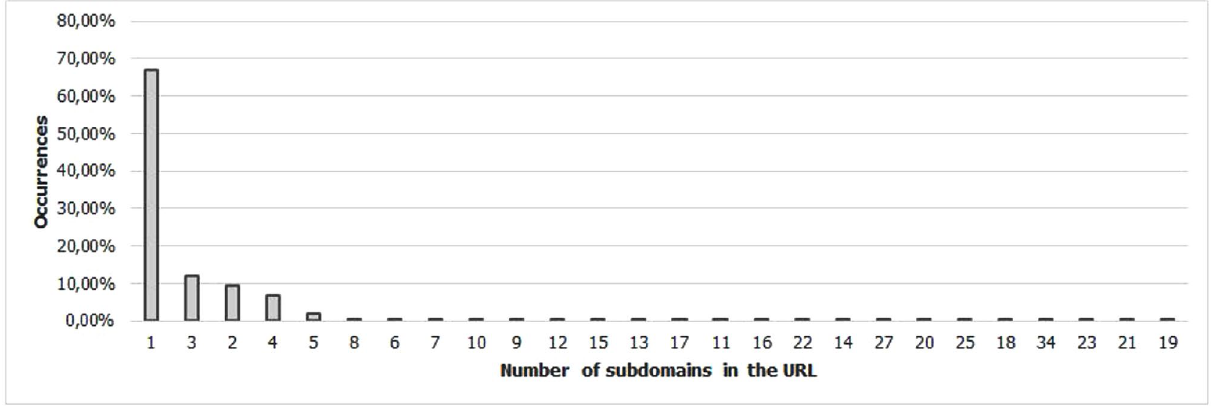
Figure 18. Number of subdomains occurences.